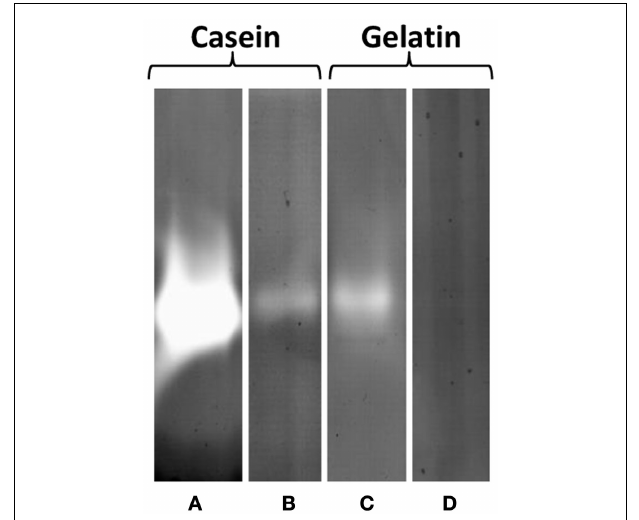
FIGURE 6 | Protease activity of EPS prepared from S. acidocaldarius biofilms, visualized in zymogram gels . EPS (5 μ g protein/lane) were electrophoresed in gels containing 0.1% casein or 0.1% gelatin and incubated at either pH 3.8 (A,C) or 7.8 (B,D) for 24h at 78°C. EPS were isolated with the CER method from biofilms collected from Brock medium plates after 4days of incubation at 78°C. Molecular mass marker: PageRuler Prestained Plus Protein Ladder